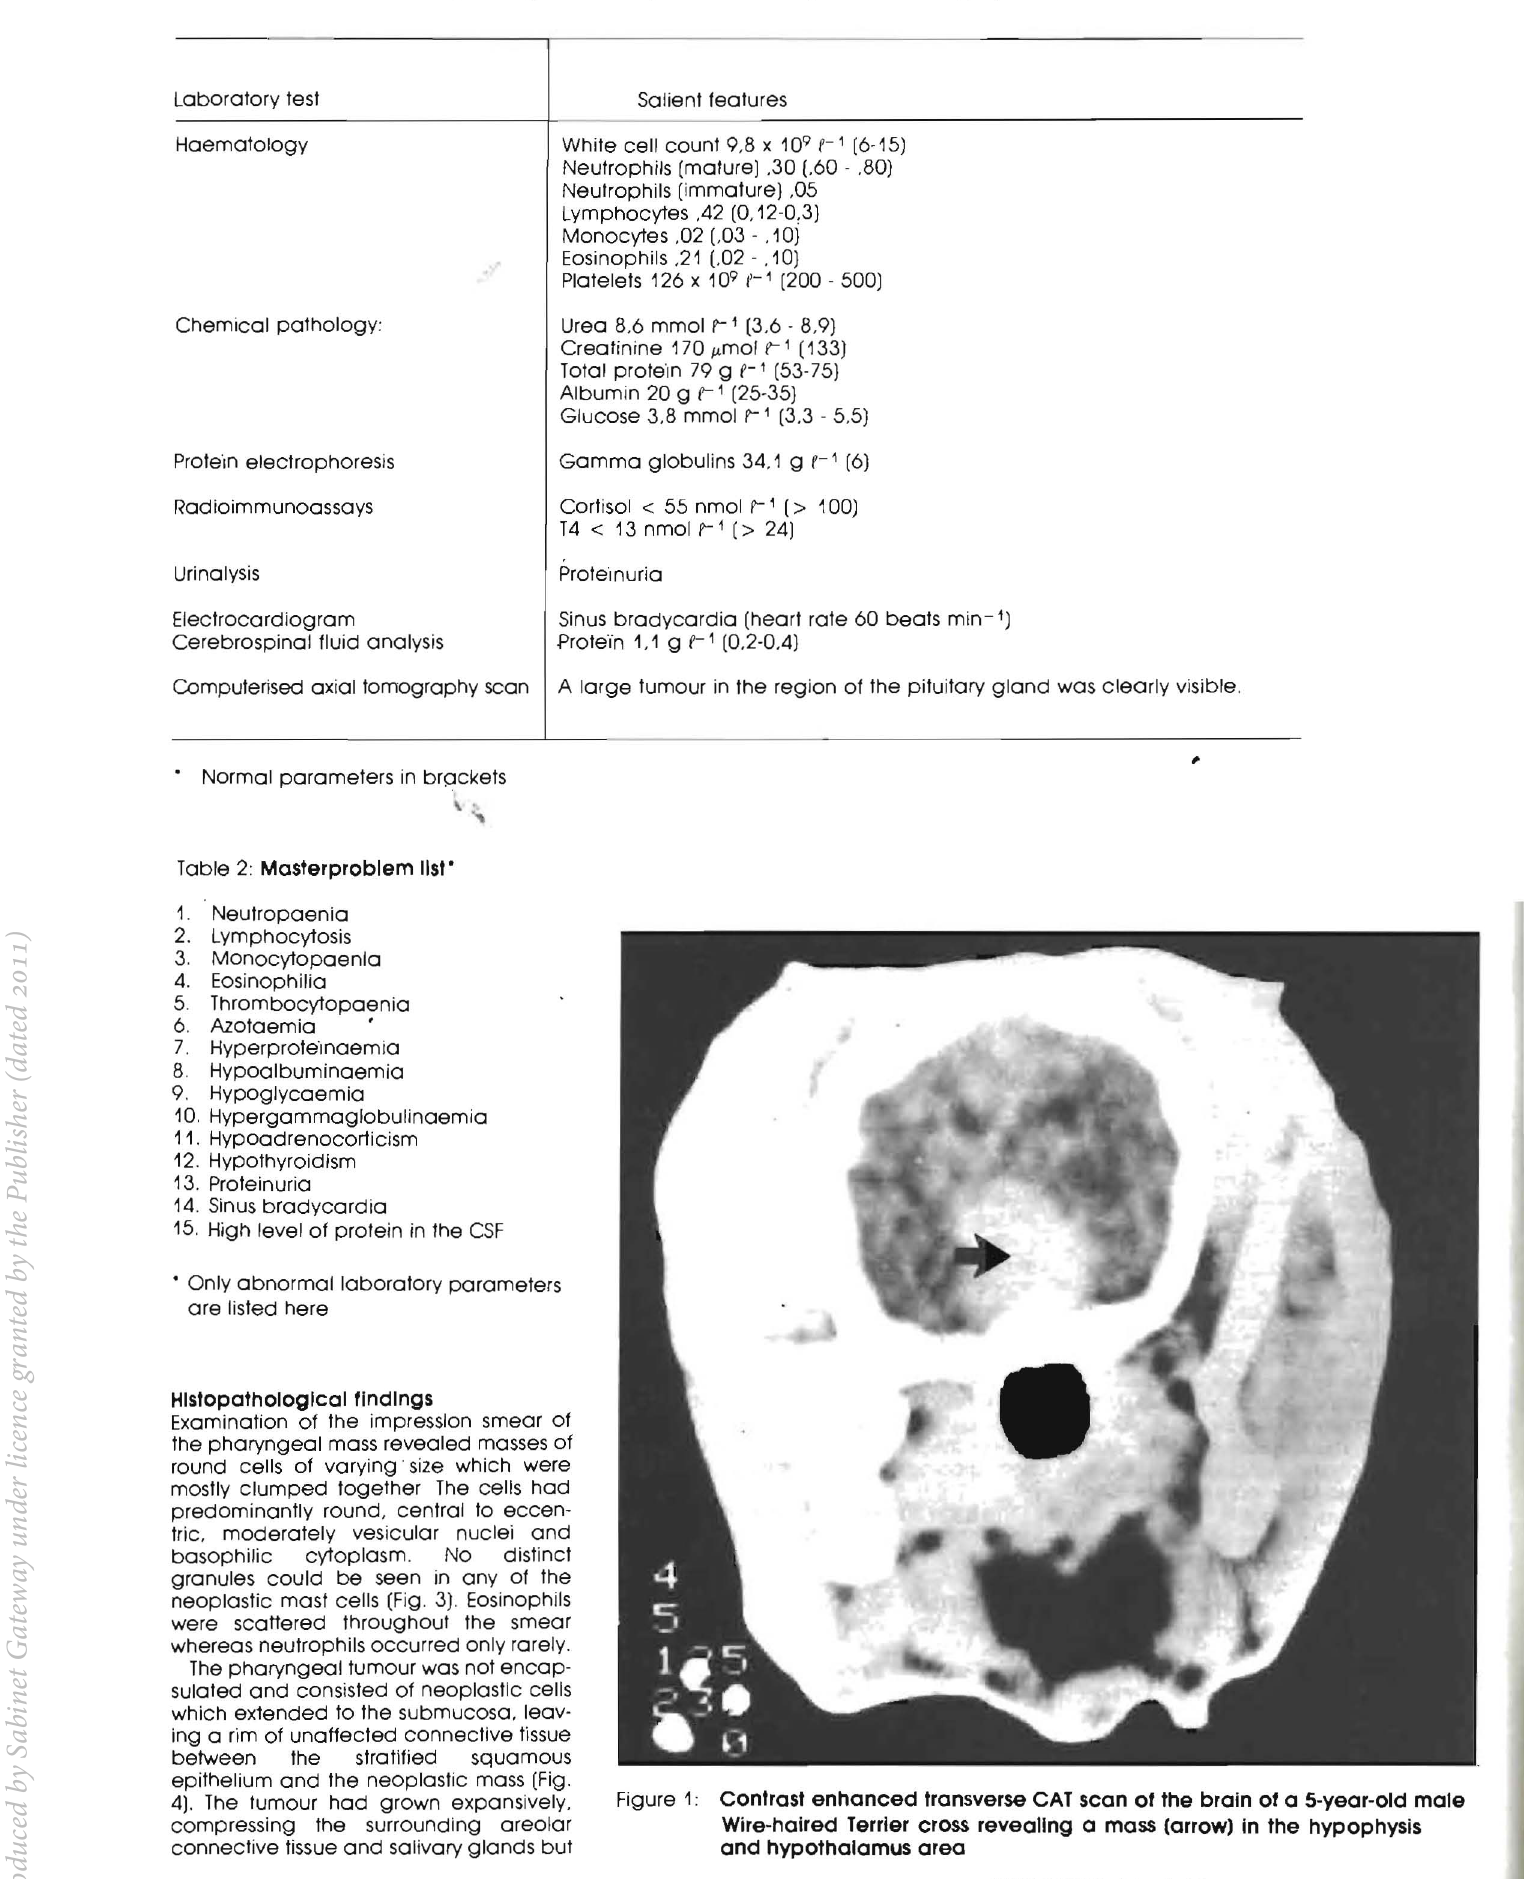
Table'1 Pertinent laboratory findings in the dog with a mastocytoma in the hypophysis'